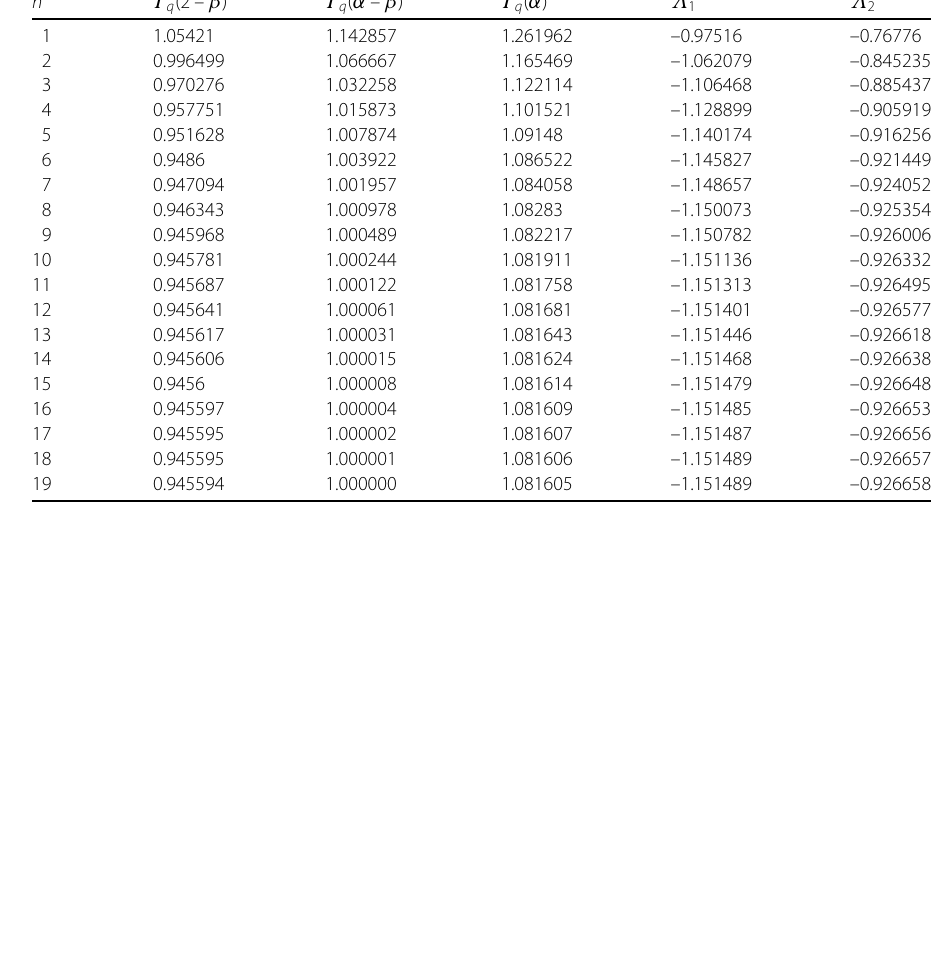
and n = 1,2, ... ,19 of 2